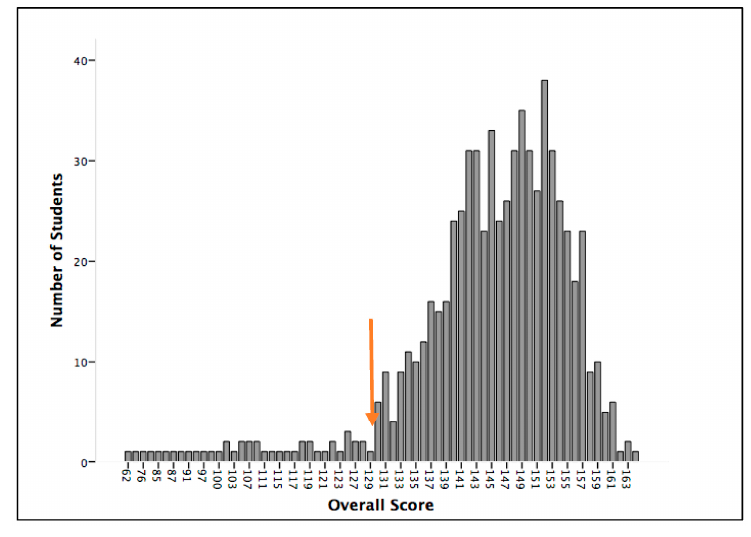
Figure 1. Distribution of Overall Scores (sum of scores in the four tasks). (Mean (M) = 144.3; Standard Deviation (SD) = 12.7). Red arrow indicates selected cut-off score.